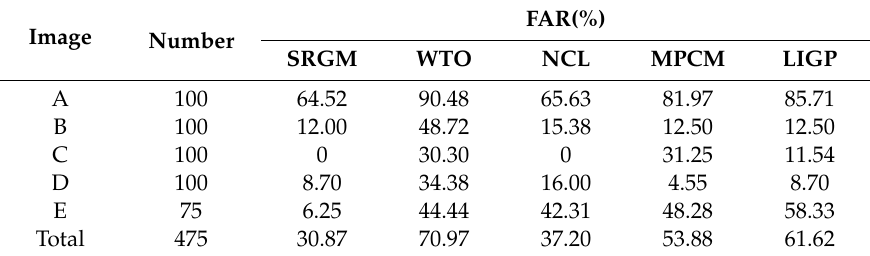
Table 3. FAR of five detection